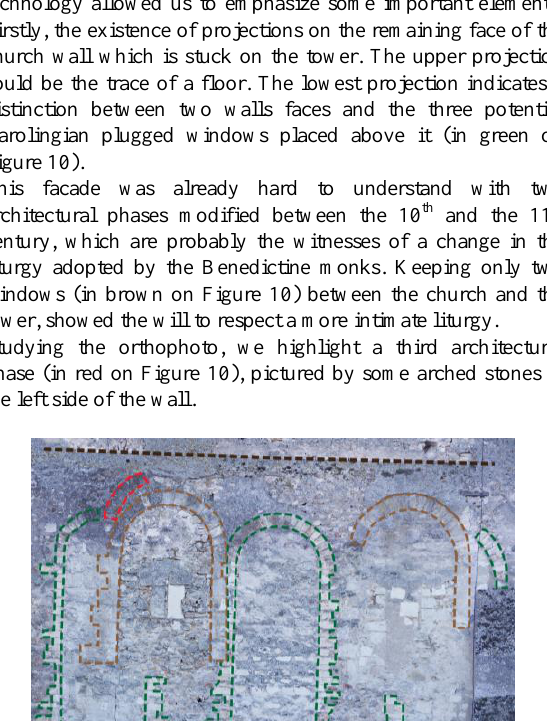
Figure 9. Orthoimage of the east face of St Paul tower